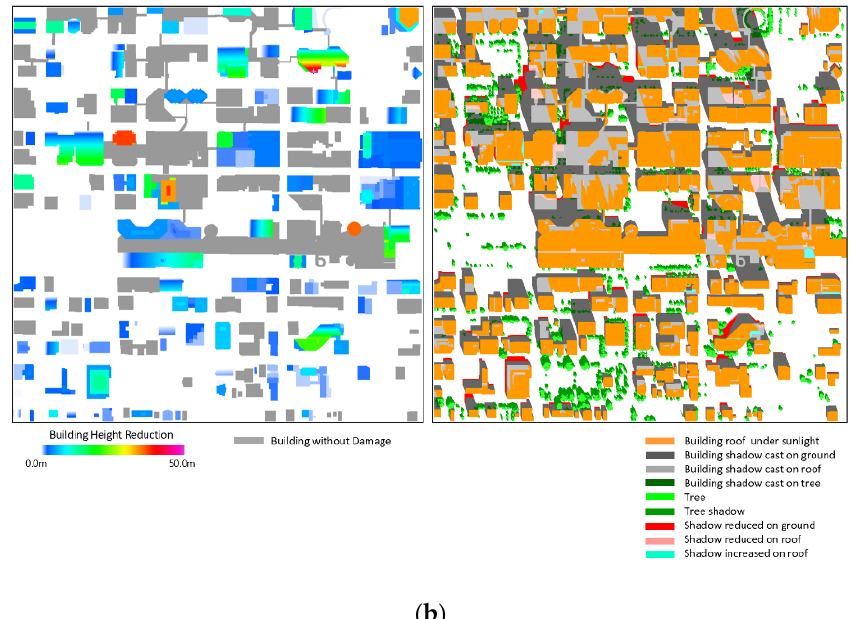
Figure 11. ( a ) Maps of building shadows changes ( right ) and reduction in building height ( left ). The total building damage area is 30% of the total building footprint area in the Case B site. ( b ) Maps of simulated building shadows and shadow changes ( right ) and reduction in building height ( left ). The total building damage area is 50% of the total building footprint area in the Case B site.